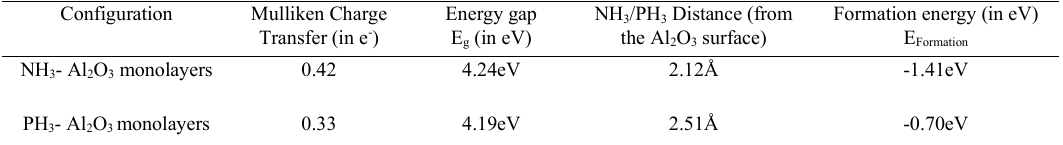
and PH on Al O -monolayers. 3 3 2 3